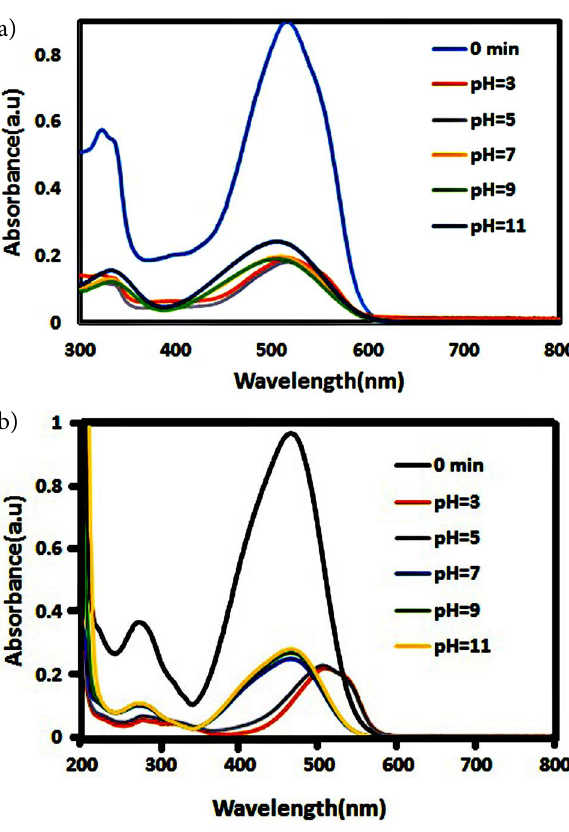
Fig 11. Time-dependent UV-vis absorption spectra for the reduc- tion (a) Rh6G and (b) MO with NaBH 4 in presence of Ag/HNTs at different pH values.